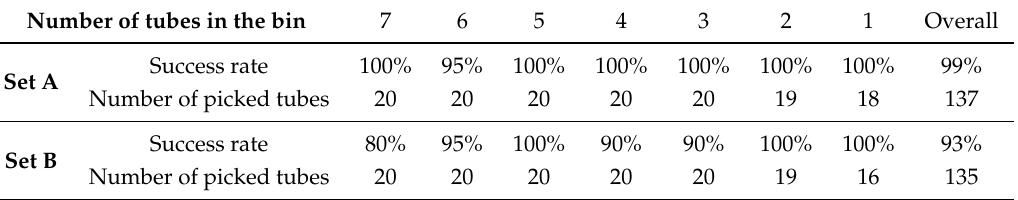
Table 4. Percentages of picked tubes that were successfully placed on the first attempt.